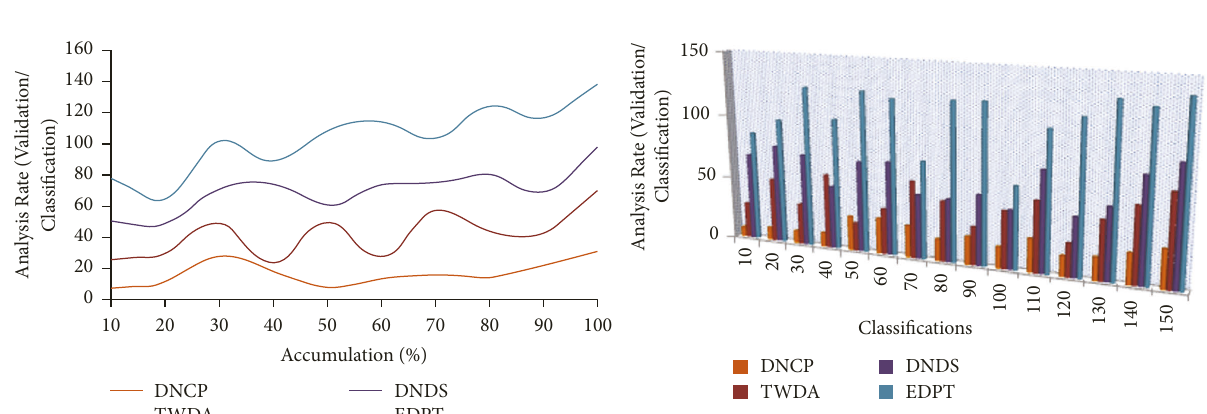
Figure 10: Analysis time.